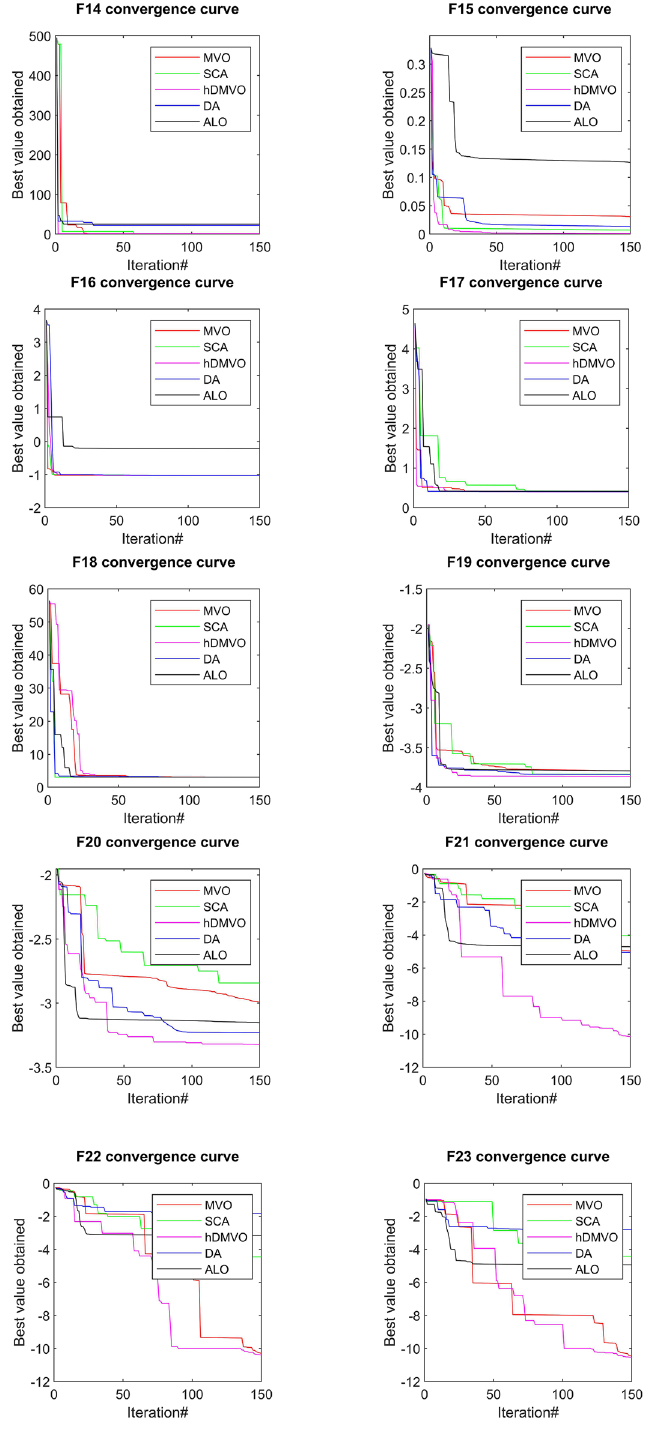
Figure 9. Convergence curves of MVO, SCA, ALO, DA, and hDMVO variants for composite